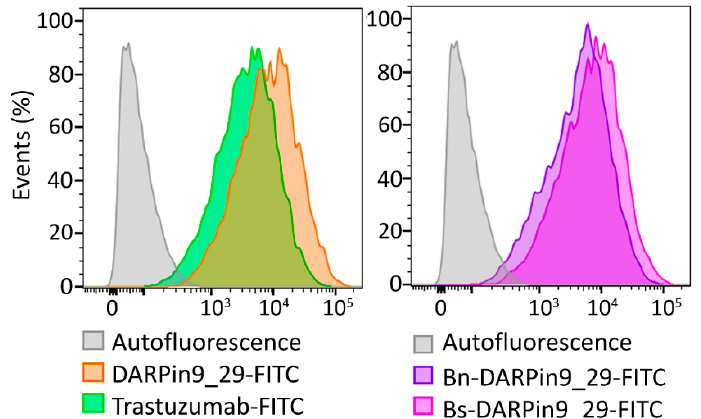
Figure 9. Flow cytometry of SK-BR-3 cells, labeled with DARPin9_29-FITC, Trastuzumab-FITC, Bn-DARPin9_29-FITC, and Bs-DARPin9_29-FITC in the fluorescence channel FL1 corresponding to FITC fluorescence.